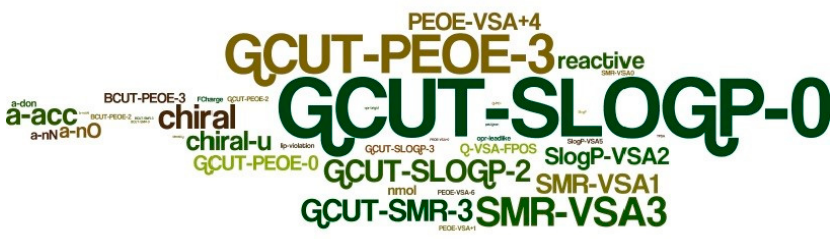
Figure 5. Appearances of descriptors in the 47 filters used to produce the anti-diabetic activity indexing model.